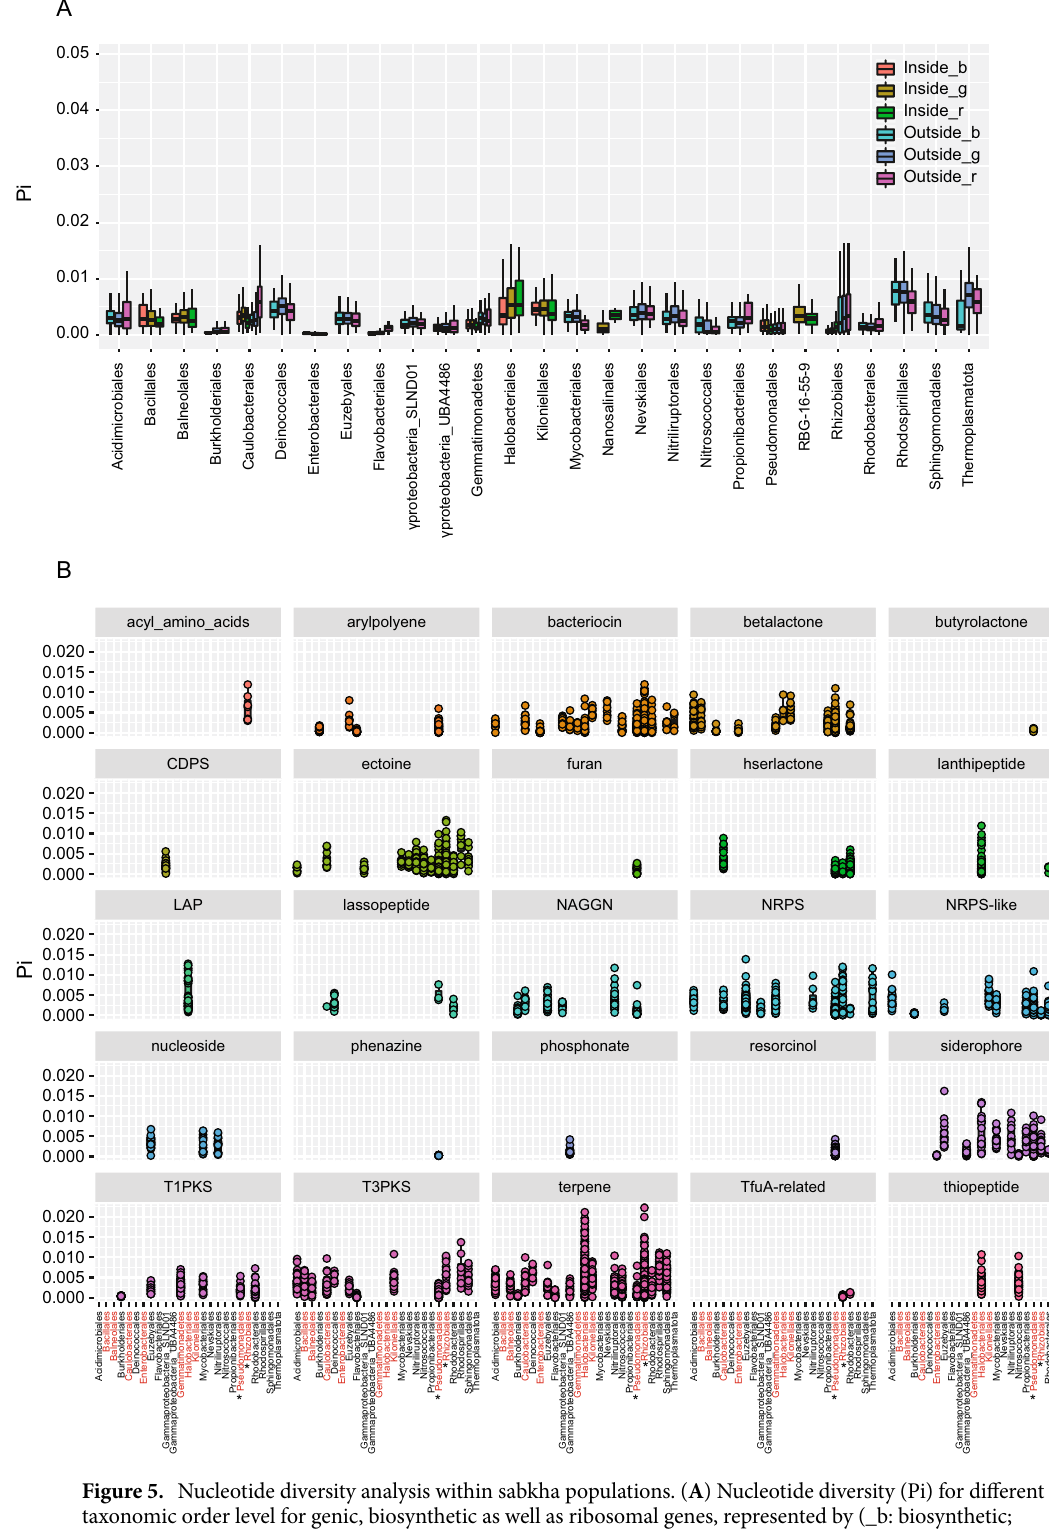
Figure 5. Nucleotide diversity analysis within sabkha populations. ( A ) Nucleotide diversity (Pi) for different taxonomic order level for genic, biosynthetic as well as ribosomal genes, represented by (_b: biosynthetic; _g: genic; _r: ribosomal). ( B ) Nucleotide diversity (Pi) for different class of biosynthetic genes for different taxonomic order level for the different metagenomic bins. Red labels identify the inner sabkha bins and star (*); identify the presence in both inner and outer